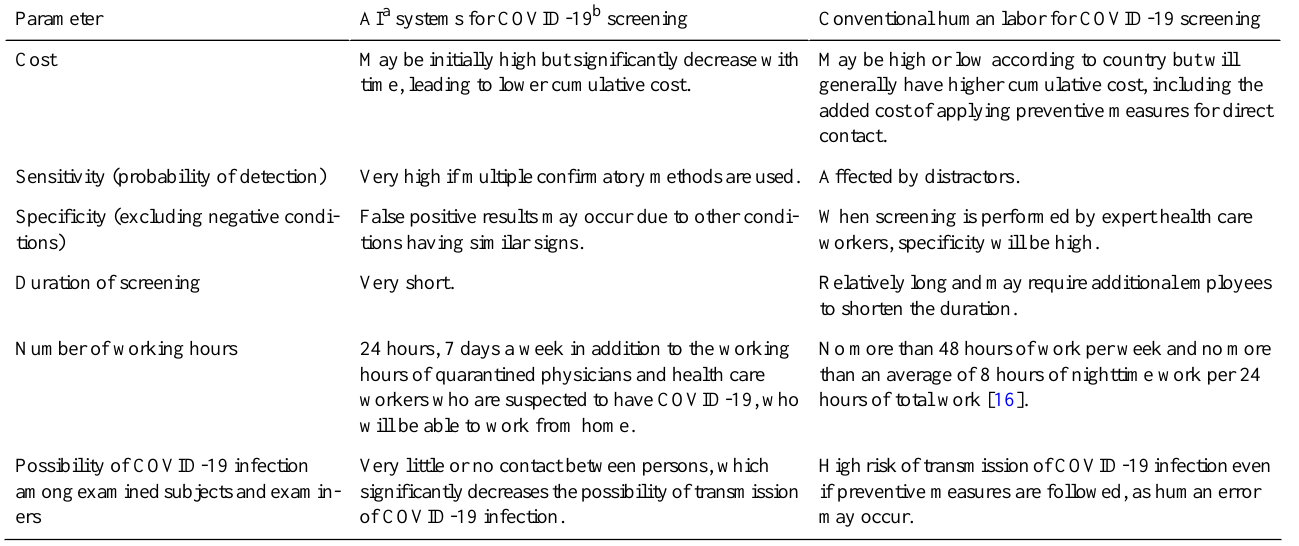
Table 1. Comparison of the cost and efficiency of AI systems versus conventional human labor for large-scale screening of COVID-19. cost.Cost signs.Specificity (excluding negative condi- tions)